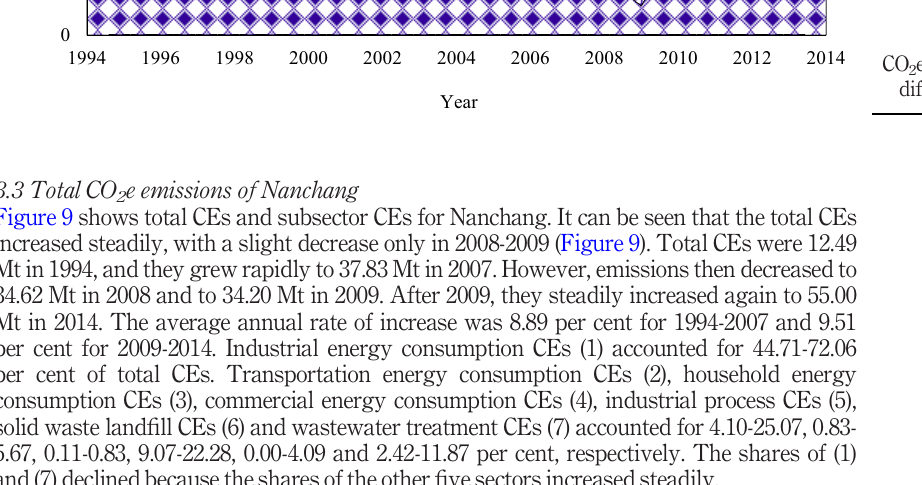
Figure 8. CO 2 e emissions from different fuel types